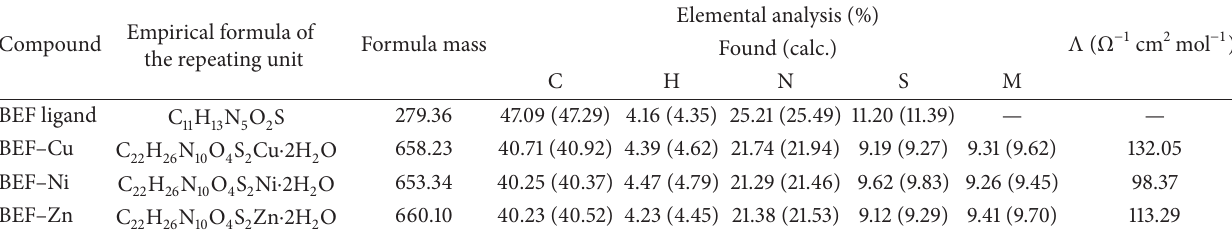
Table 1: Physicochemical and analytical data.